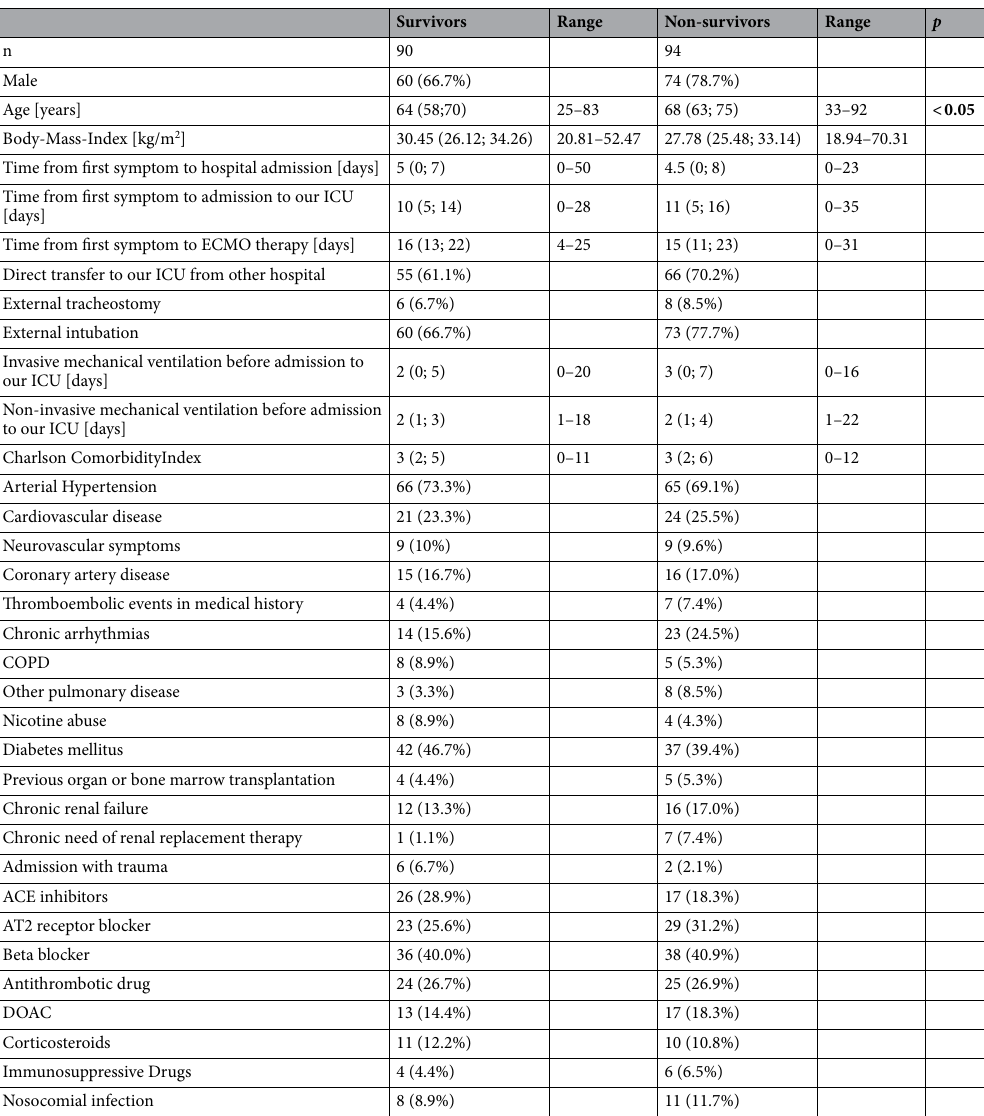
Table 4. Patients characteristics survival. Data are median (Interquartile range) or n (%). Significant values are in [bold]. ICU Intensive care unit, ECMO extracorporeal membrane oxygenation, NIV Non-invasive ventilation, COPD Chronic obstructive pulmonary disease, ACE Angiotensin-converting enzyme, AT2 Angiotensin II, DOAC Direct oral